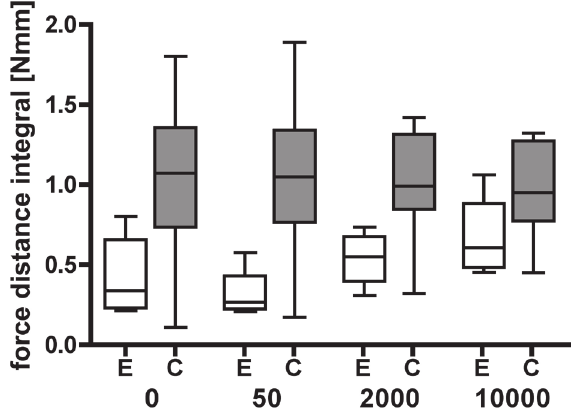
Figure 4- Retention force values measured at the 4 particular points in time (cycle 0; 50; 2,000; 10,000) for group E (electroplated female part) and group C (cast female part)